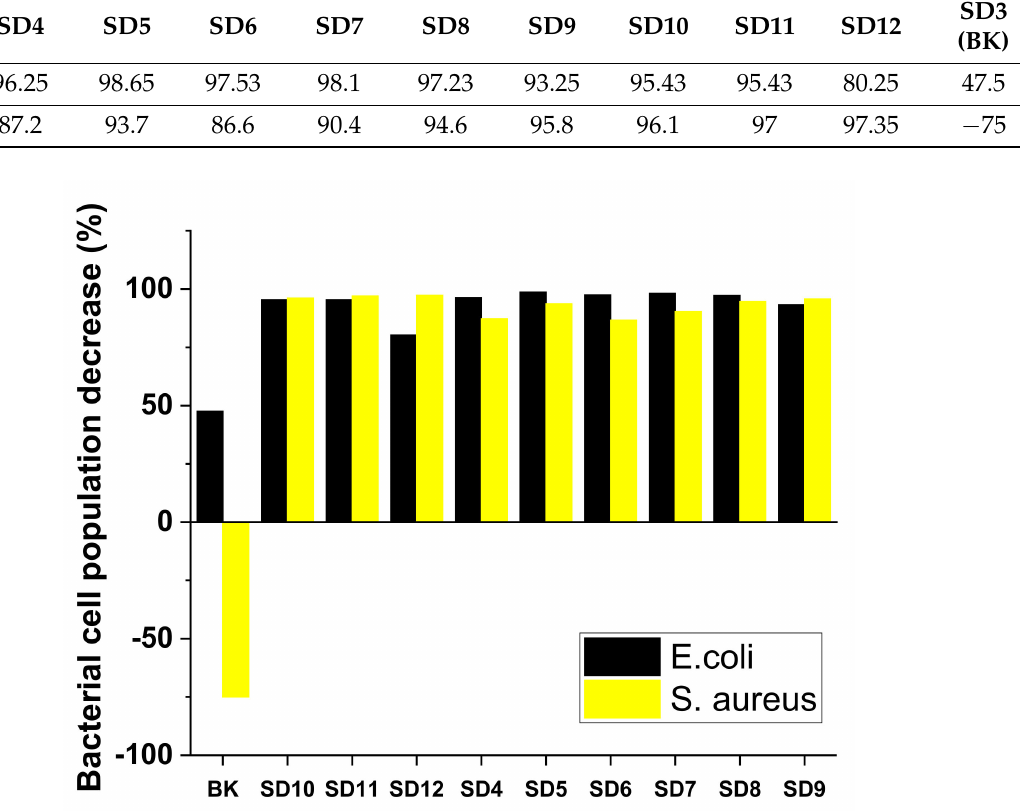
Table 5. Bacterial cell population decrease (%) after 2 h of contact with decontamination solutions. Micro- Organism/Sample